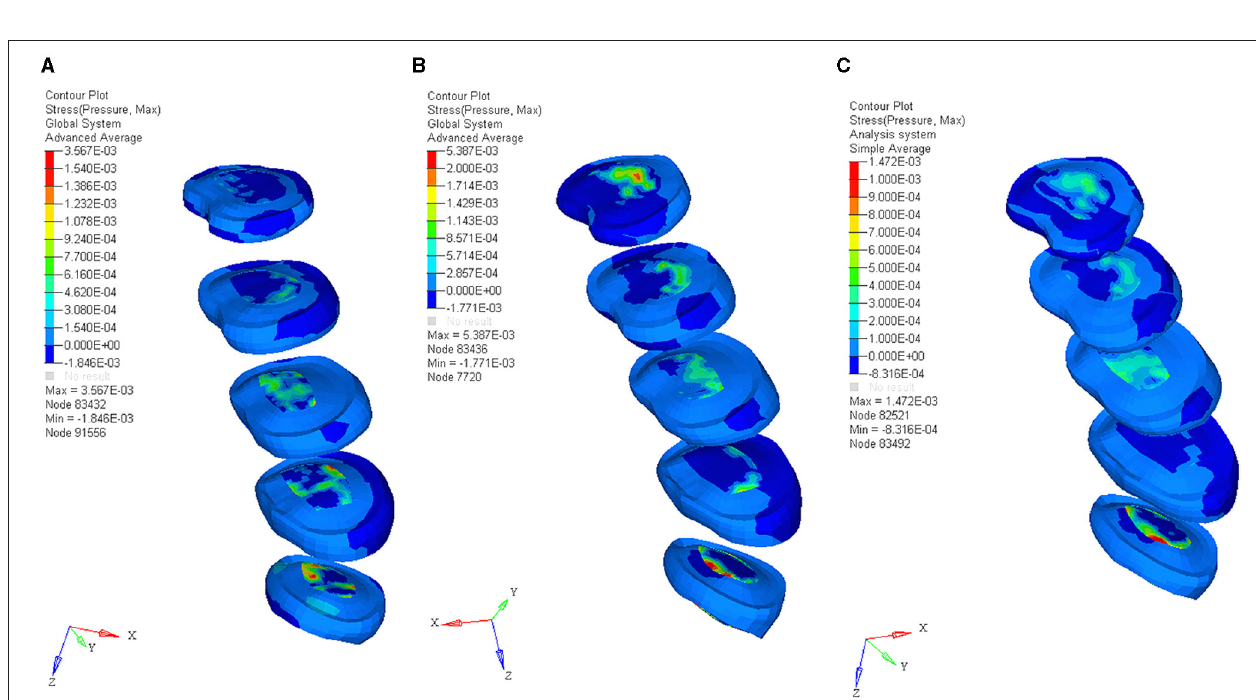
FIGURE 5 | The maximum intradiscal pressure of bending without lifting weight posture (A) , the bending with lifting 3-year-old child posture (B) , and upright with 3-year-old child posture (C) .